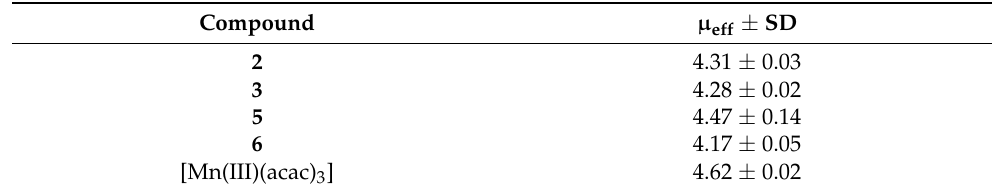
Table 1. Effective magnetic susceptibility of the Mn complexes measured using the Evans NMR method ( n = 3, SD = standard